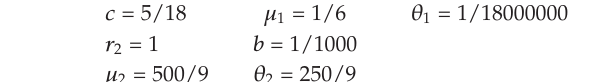
Table 1: The nondimensionalization parameters of bilinear model (cid:4) 2.5 (cid:5) .